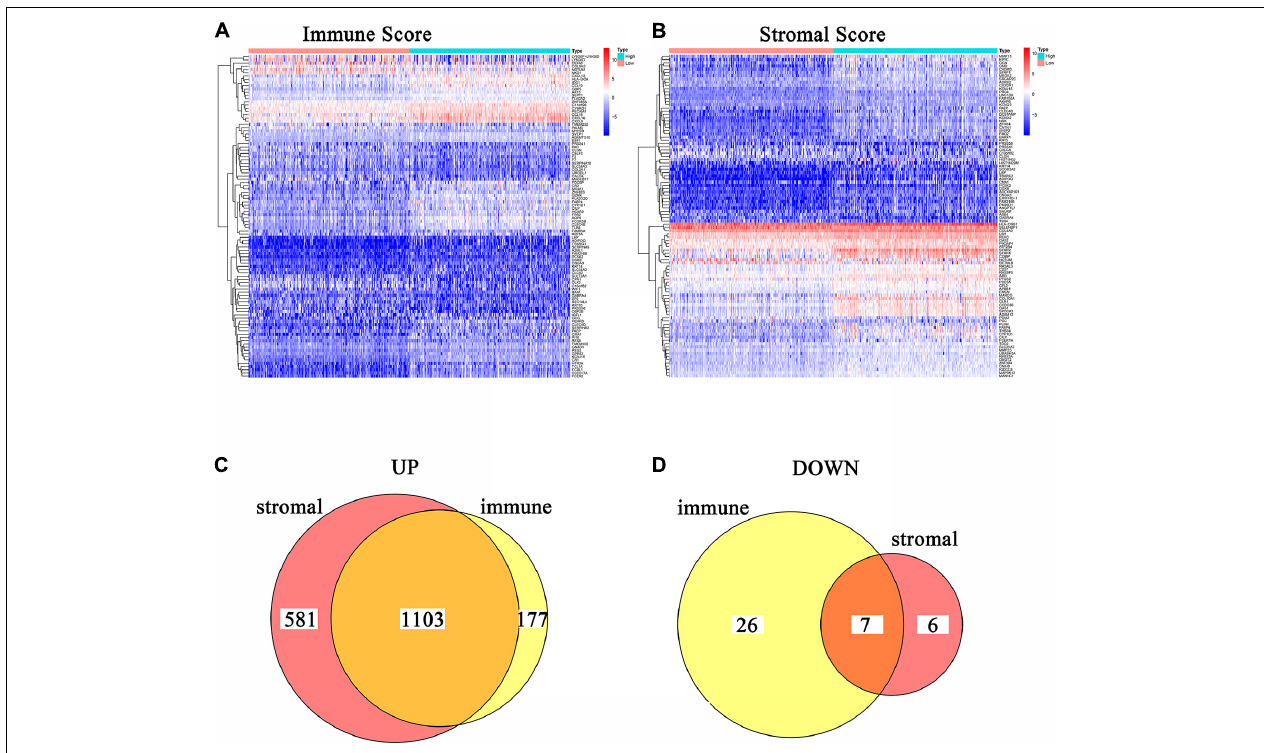
FIGURE 2 | Heatmaps and Venn plots of DEGs. (A) Heatmap for DEGs conducted by comparing high Immune Score tumor samples with low Immune Score tumor samples. Row name: the gene name. Column name: the ID of samples which are not shown in plot. DEGs were examined by Wilcoxon rank sum test with q = 0.05 and log2 fold − change > 1 as the significance threshold. (B) Heatmap for DEGs conducted by comparing high Stromal Score tumor samples with low Stromal Score tumor samples. Row name: the gene name. Column name: the ID of samples which are not shown in plot. DEGs were examined by Wilcoxon rank sum test with q = 0.05 and log2 fold − change > 1 as the significance threshold. (C,D) Venn plots of commonly overexpressed and downexpressed DEGs shared by Immune Score and Stromal Score.